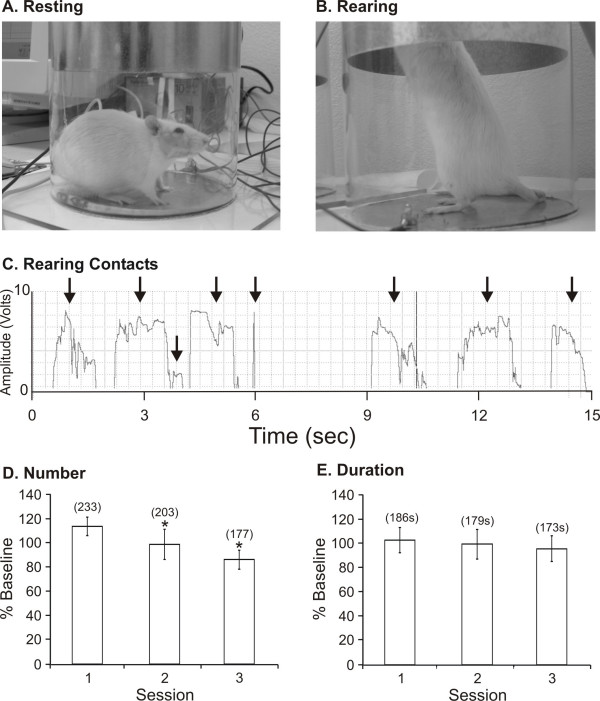
Illustrated is an animal that is at rest (A) and rearing (B) in the rearing assay testing device. An example of the trace recording is illustrated in panel C with the arrows denoting distinct rearing events. Animals (N = 12) tested on three consecutive days displayed a significant decrease (*P < 0.05) in the number of reaches (D), but not in the total rearing duration (E). The raw number of events or time (s) is denoted in the parentheses.